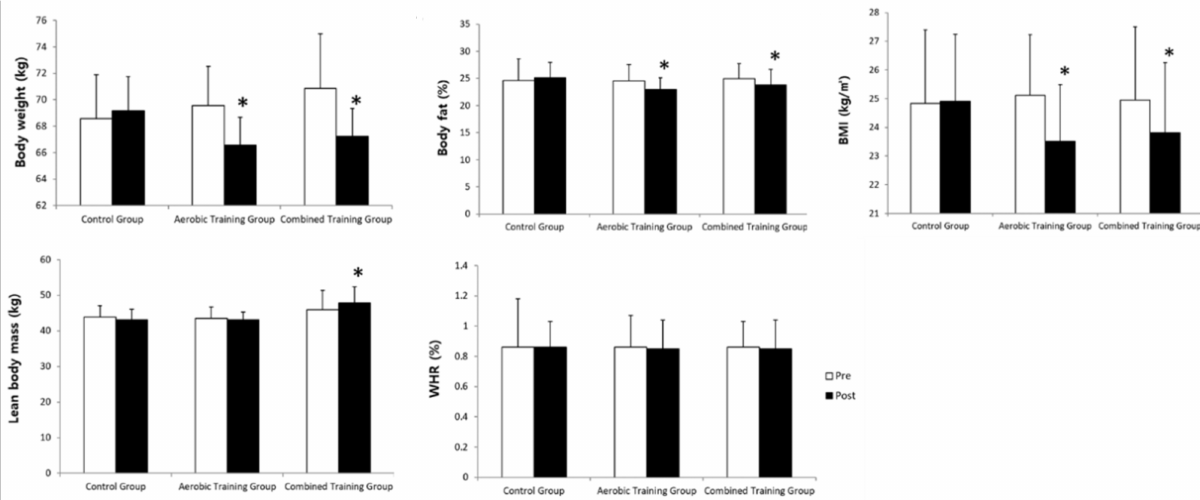
Figure 2. Change of body composition after 12 week exercise training. 2-way repeated ANOVA for group and time: Body weight, Group F 2,51 = 3.234 ( p < 0.05), Time F 1,51 = 5.345 ( p < 0.05), G × T F 2,51 = 14.512 ( p < 0.05); Body fat, Group F 2,51 = 4.167 ( p < 0.05), Time F 1,51 = 3.317 ( p < 0.05), G × T F 2,51 = 4.512 ( p < 0.05); BMI, Group F 2,51 = 4.177 ( p < 0.05), Time F 1,51 = 4.117 ( p < 0.05), G × T F 2,51 = 8.912 ( p < 0.05); Lean body mass, Group F 2,51 = 4.231 ( p < 0.05), Time F 1,51 = 2.356 ( p > 0.05), G × T F 2,51 = 5.534 ( p < 0.05); WHR, Group F 2,51 = 2.189 ( p > 0.05), Time F 1,51 = 1.389 ( p > 0.05), G × T F 2,51 = 2.667 ( p > 0.05). *: p < 0.05 vs. Pre-test.